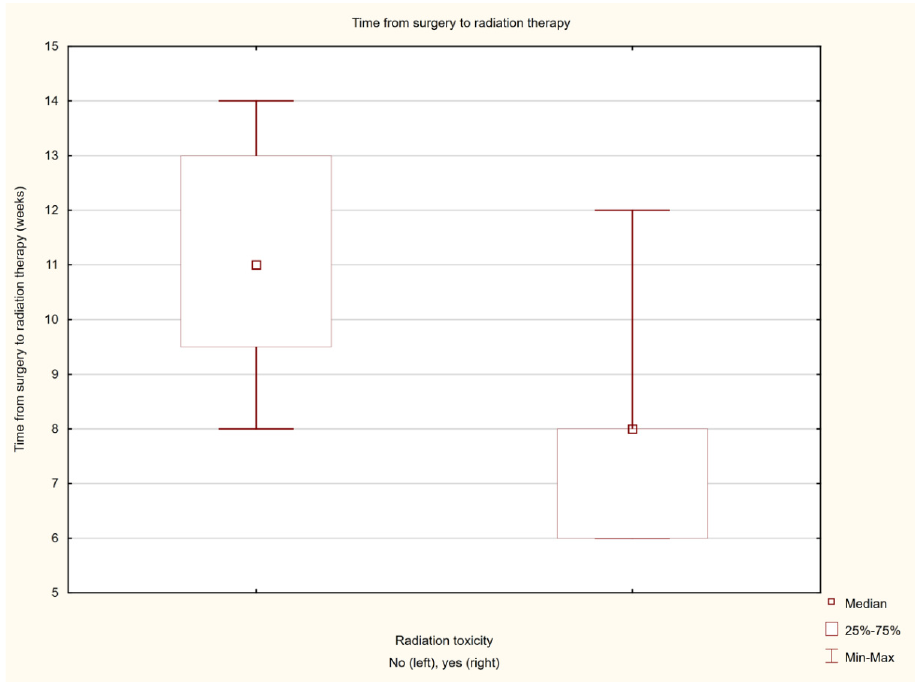
Cancers 2022 , 14 , 5614 Figure 4. Analysis of the influence of time from surgery on the severity of post-radiation reaction.